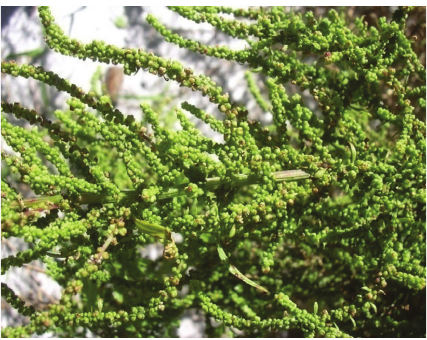
Figure 1: Chenopodium ambrosioides